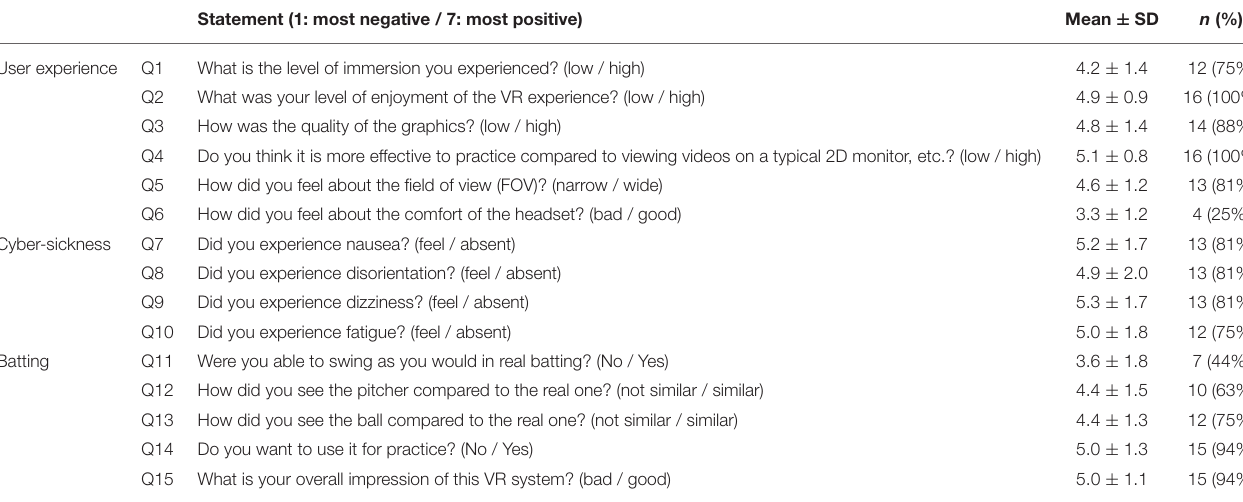
TABLE 1 | Questionnaire on the VR experience ( N =